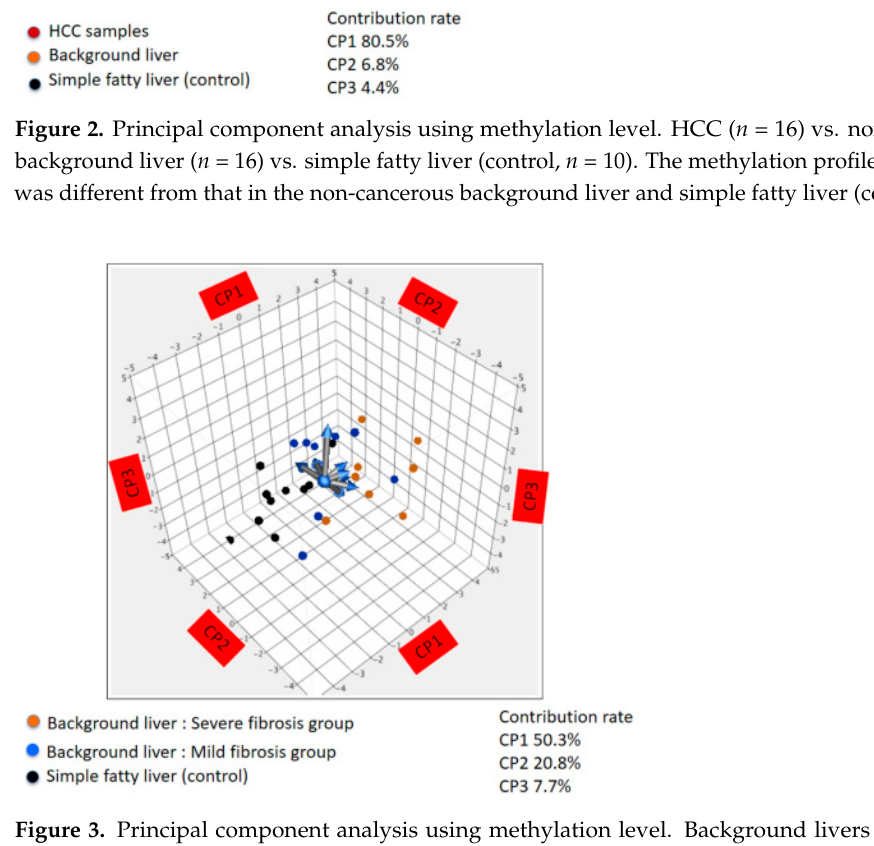
Figure 3. Principal component analysis using methylation level. Background livers with severe fibrosis ( n = 8) vs. mild fibrosis ( n = 8) vs. simple fatty liver (control, n = 10). The methylation profiles from the background livers with severe fibrosis and mild fibrosis tended to overlap. The contributions of each principal component were CP1 (50.3%), CP2 (20.8%), and CP3 (7.7%).